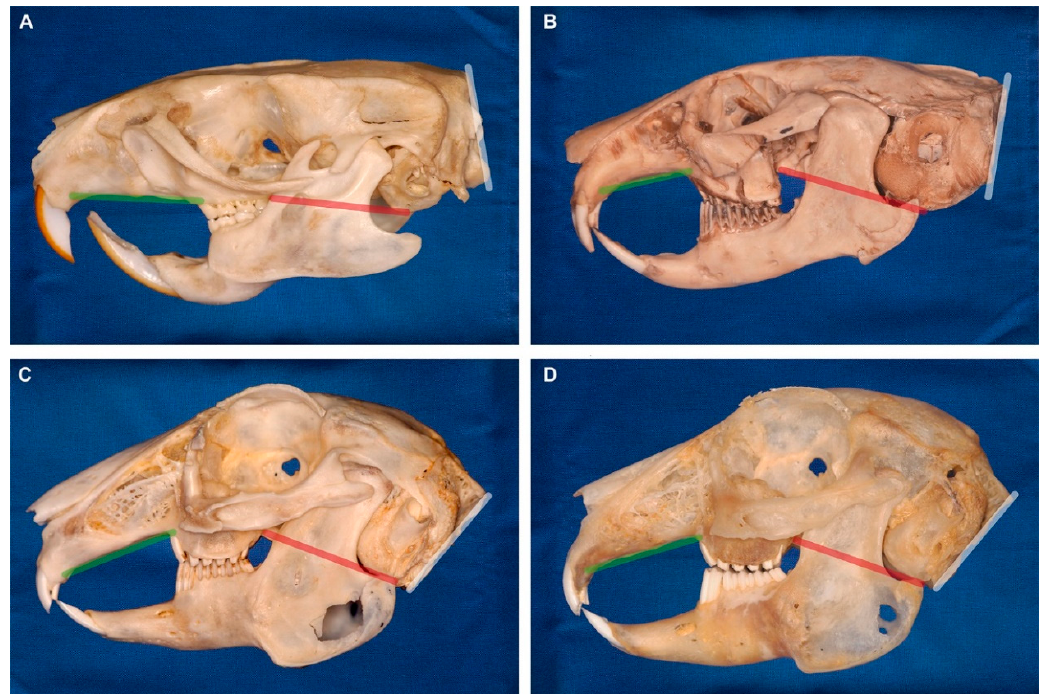
Figure 8. Cranial flexion in rodents and the sister taxon lagomorphs (ochotonids and leporids). The red line represents the orientation of the basicranium. The green line indicates the palatal plane. The white line shows the orientation of the occiput and the foramen magnum. ( A ) Rat (rodent). ( B ) Pika (ochotonid). ( C ) Wild rabbit (leporid). ( D ) Pet rabbit (leporid). Note the pronounced flexion in lagomorphs. The skulls are scaled to same length and oriented with the cranial base plane being horizontal.